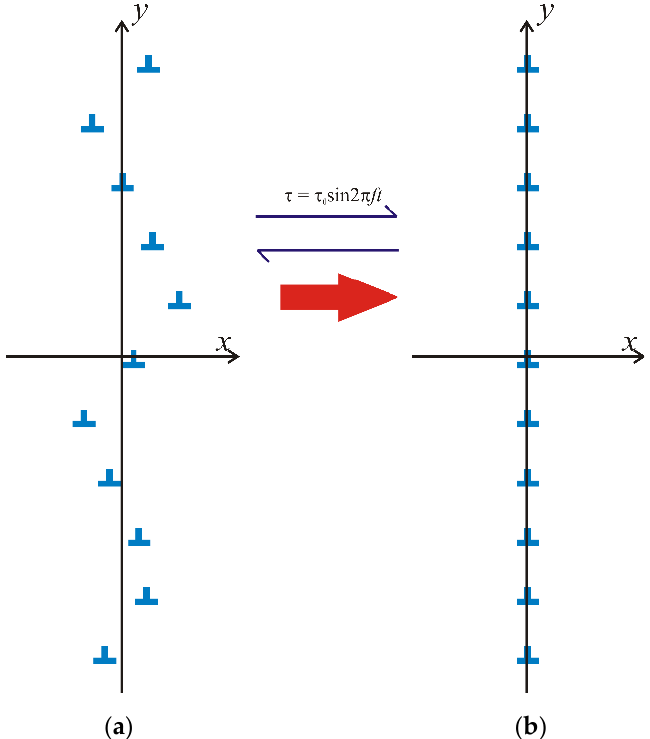
Figure 16. A schematic representation of a loose dislocation wall ( a ) and ideal, flat wall formed due to ultrasonic treatment ( b ).